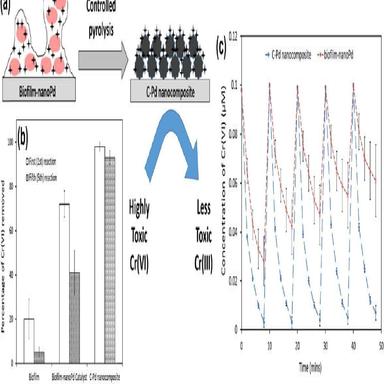
(a) Schematic illustration for the preparation of CePd composite, (b) Cr(VI) reduction of the CePd nanocomposite, biofilm nanoPd, and biofilm-only samples on the 1st and 5th catalytic reactions, and (c) Cr(VI) reduction of CePd nanocomposite and biofilm nanoPd samples over five catalytic reactions).